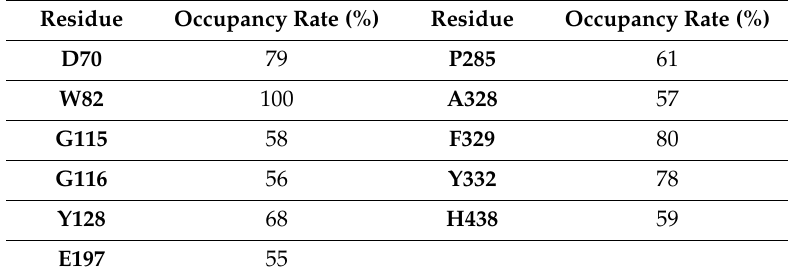
Table 5. The hydrophobic interactions residues in BChE and their corresponding occupancy rates. Residue Occupancy Rate (%) Residue Occupancy Rate (%) D70 79 P285